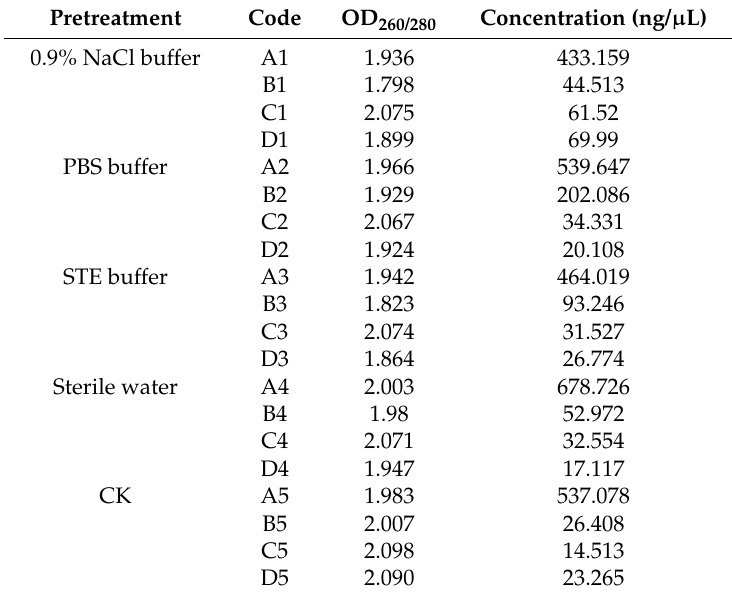
Table 3. DNA purity and concentration of the different pretreatments. The code in this table corresponds to the code in Table